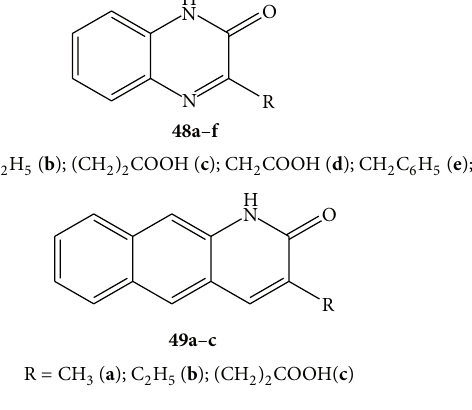
Figure 16: Chemical structures of Compounds tested.